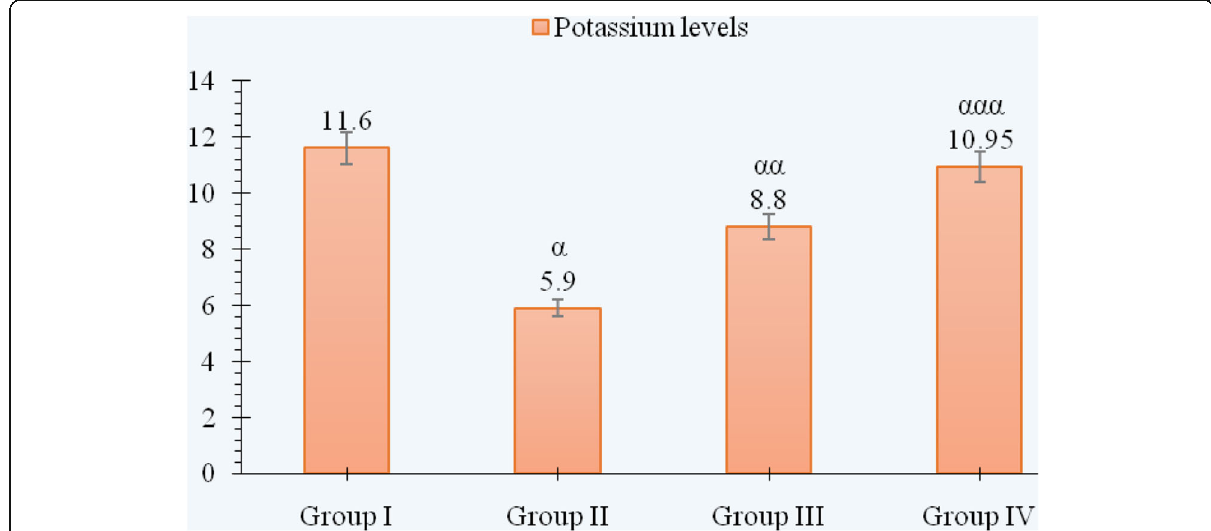
Fig. 9 Potassium levels of various groups. α p < 0.001 as compared to group I, αα p < 0.05 as compared to group II and ααα p < 0.001 as compared to group